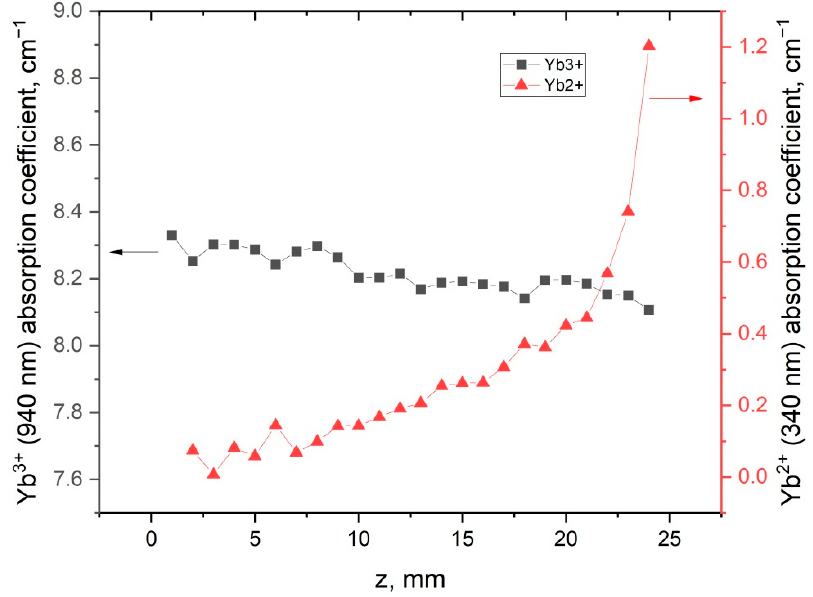
Figure 6. Yb 3+ and Yb 2+ absorption-coefficient along the LiY 0.8 Yb 0.2 F 4 crystal.